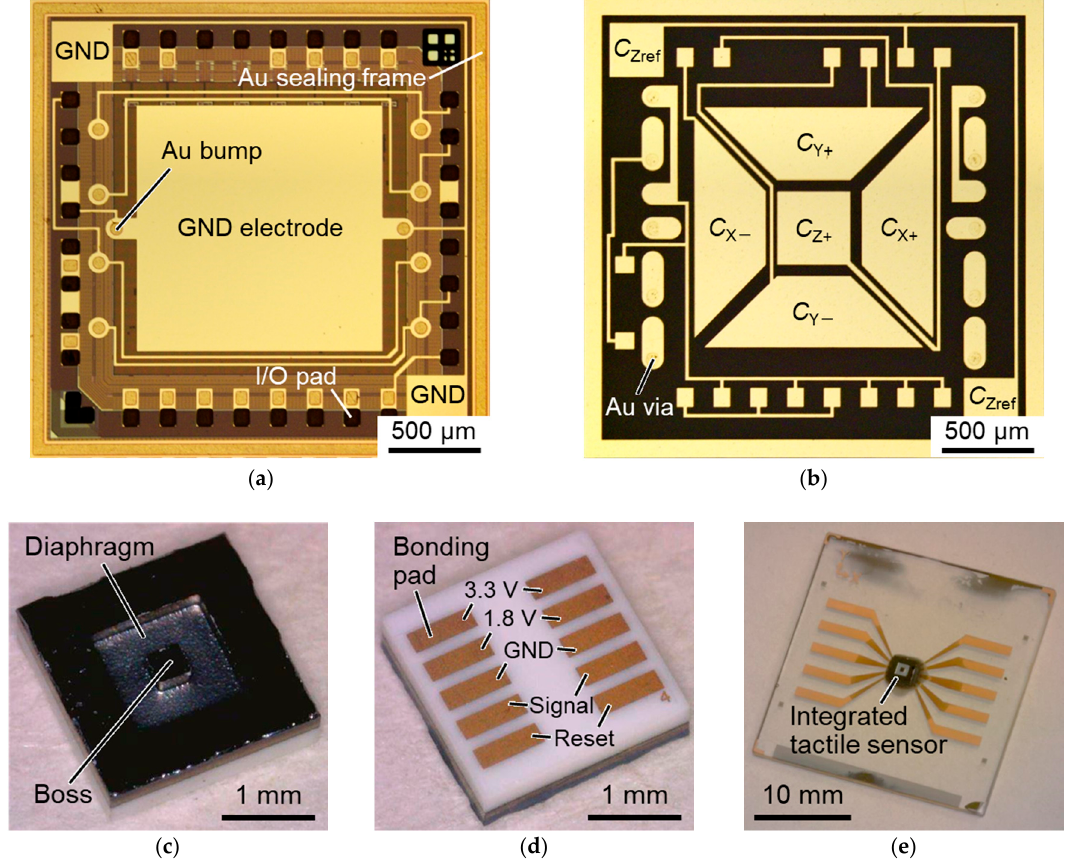
Figure 8. Fabrication results: Optical micrographs of ( a ) CMOS substrate with Au bumps, an Au sealing frame and a GND electrode and ( b ) low temperature cofired ceramic (LTCC) interposer substrate with 3-axis sensing electrodes; ( c ) Front side and ( d ) back side views of a fabricated tactile sensor; ( e ) Surface-mounted tactile sensor on a glass substrate with interconnections.